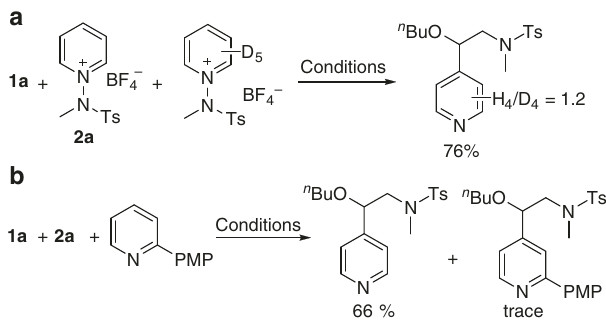
Fig. 8 Control experiment. a Kinetic isotope experiments. b Reaction with mixtures of 2a and 2- p -methoxyphenyl (PMP)-substituted